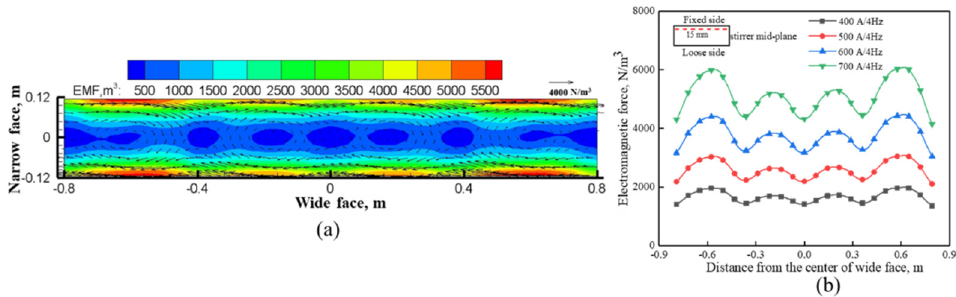
Figure 3. Distribution of ( a ) time-average electromagnetic force at the center of stirrer and ( b ) elec- tromagnetic force under different EMS currents.